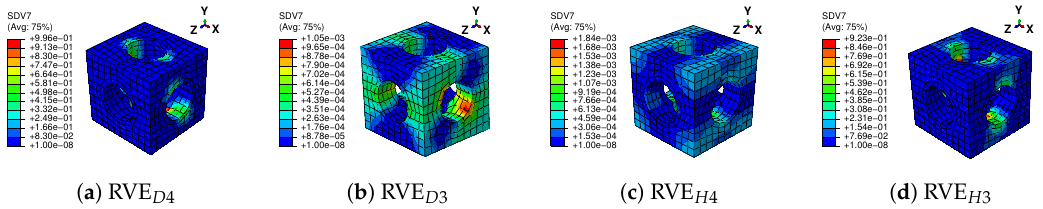
Figure 19. Distribution of martensitic volume fraction ¯ f t (named SDV7 in colorbar) on the RVEs with the prescribed displacement in the Y direction reaching 0.5 mm and ξ = 40.7%.